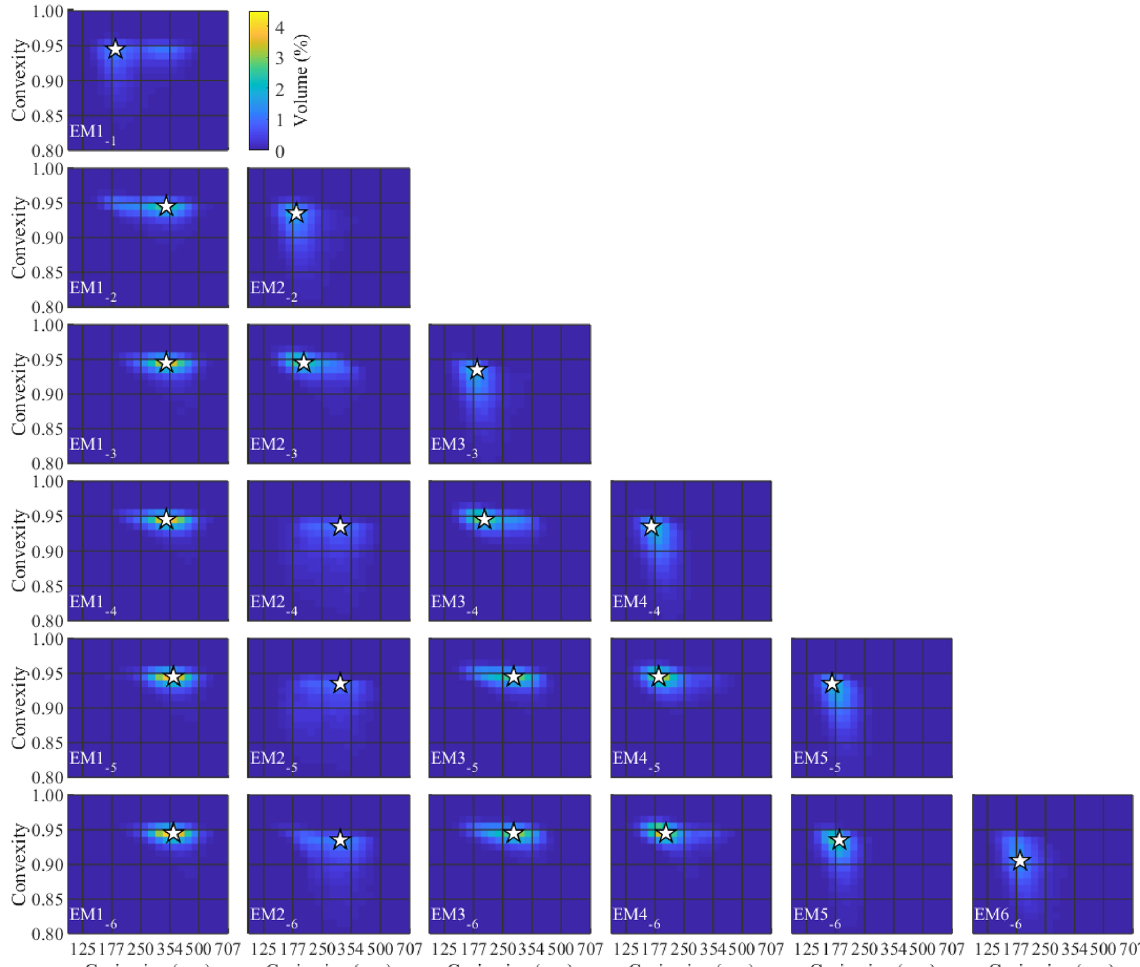
Figure A10. Endmember distributions computed for the ConD2d dune dataset (1EM to 8EM solutions).